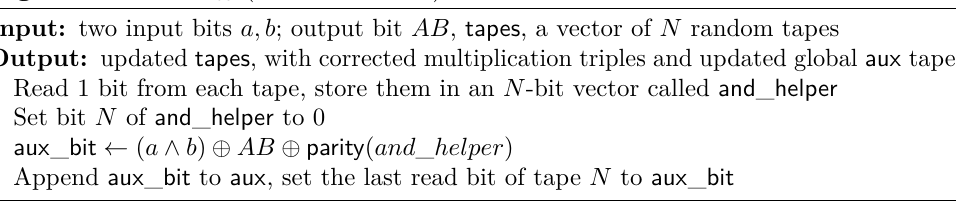
Algorithm 14 Simulation of Online Phase in Picnic2 (after Section 5.2)